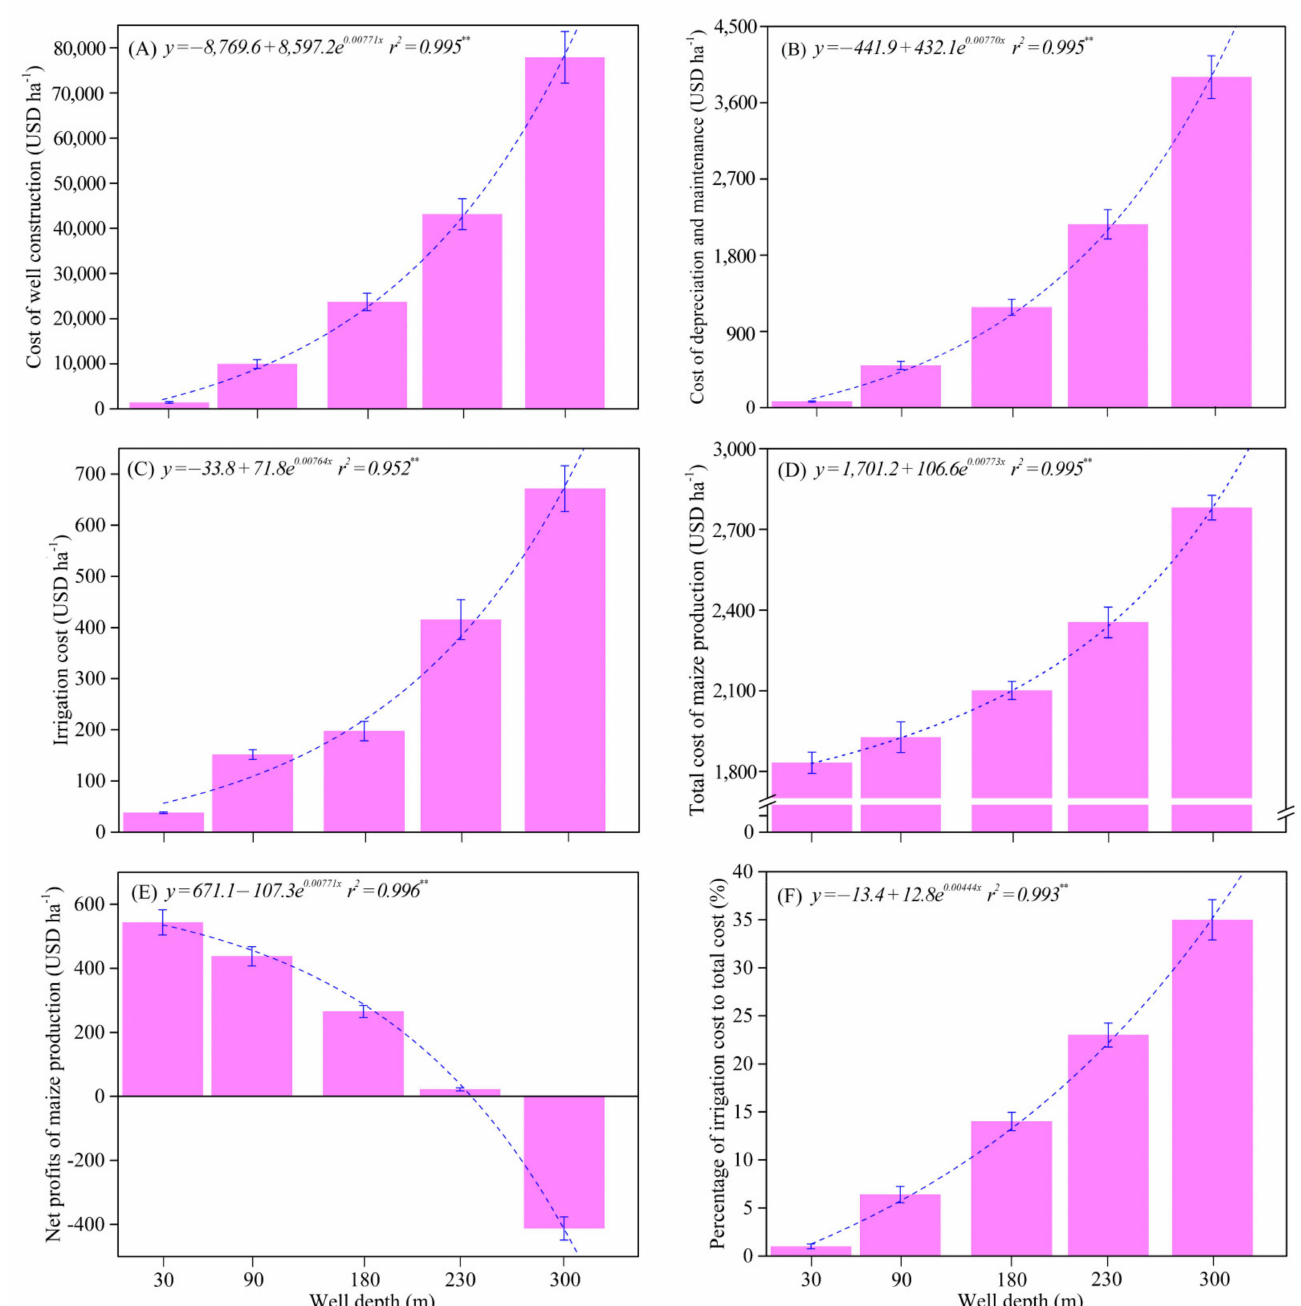
Figure 5. Costs and benefits in maize production and their relationships with well depth according to the survey data collected in the North China Plain. ( A ) cost of well construction; ( B ): cost of depreciation and maintenance; ( C ): irrigation cost; ( D ): total cost of maize production; ( E ): net profits of maize production; ( F ): percentage of irrigation cost to total cost. ** indicates extremely significant correlation at p <